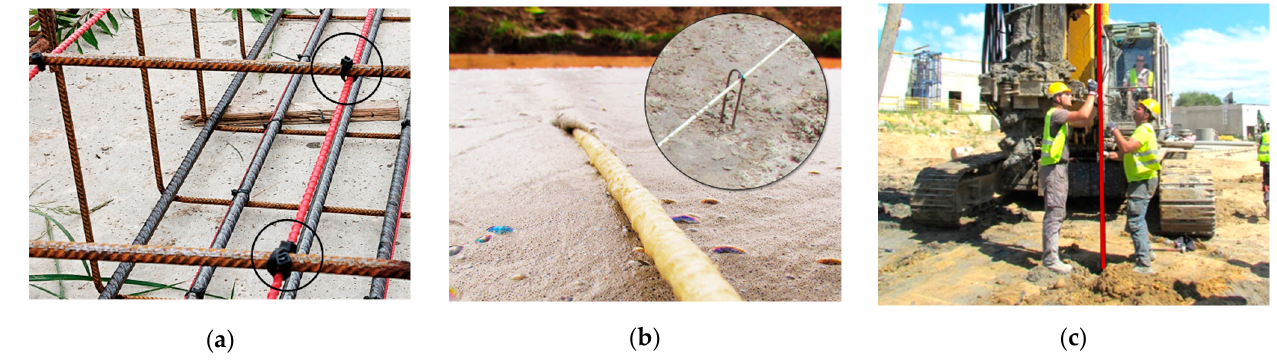
Figure 6. Possibilities of the sensors’ embedding methods: ( a ) tying to the existing reinforce- ment; ( b ) using special mounting brackets in the foam concrete without reinforcement; ( c ) application of advanced system in a concrete column without reinforcement.